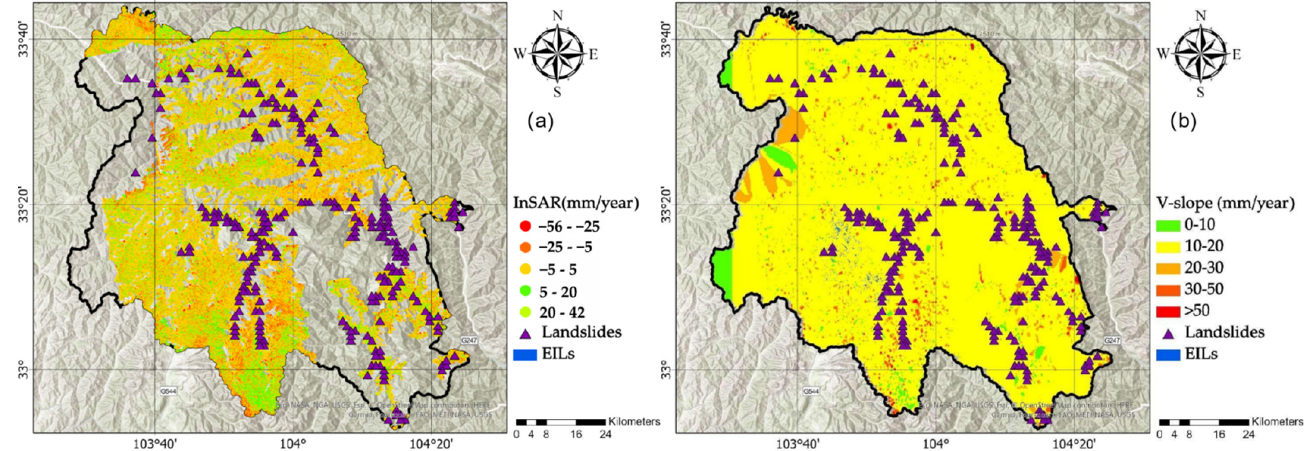
Figure 7. ( a ) InSAR deformation of study area. ( b ) The index of v slope , where each cell is 30 m × 30 m, and 𝑣 (cid:3046)(cid:3039)(cid:3042)(cid:3043)(cid:3032) reverse directional deformation leading to the landslide is considered to be 0.